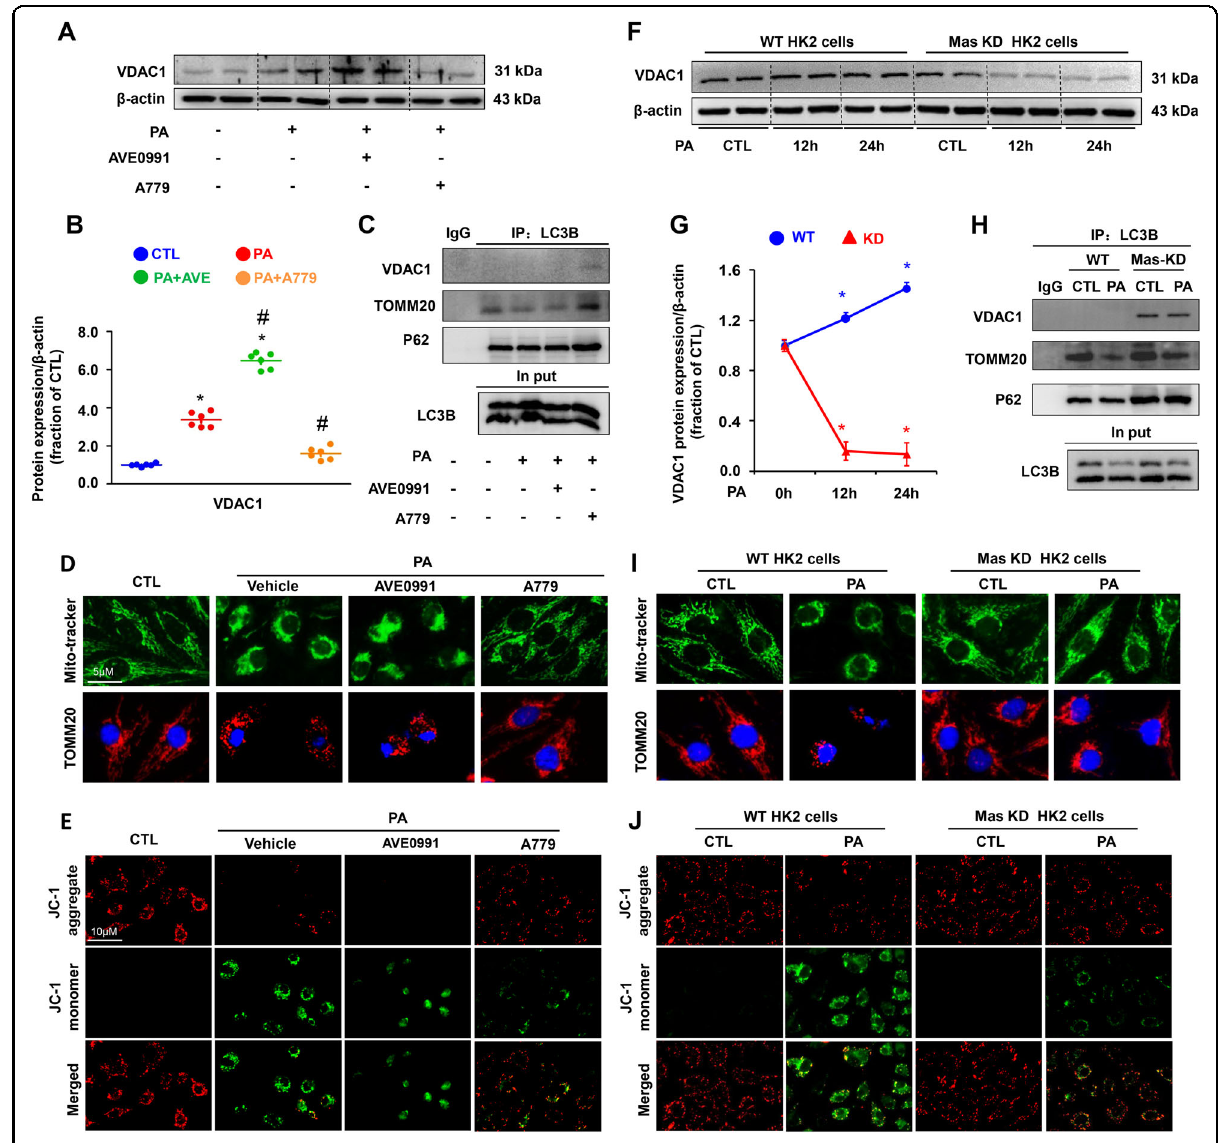
Fig. 6 Mas activation was associated with increased VDAC1 expression and impaired mitochondrial morphology and potential in HK2 cells treated with PA. A and B Representative immunoblots and corresponding densitometry analysis of VDAC1 protein abundance in HK2 cells pretreated with AVE0991 or A779 followed by PA for 24 h. β -actin was used as a loading control. C VDAC1 and TOMM20 were detected by LC3 tag labeling in HK2 cells pretreated with AVE0991 or A779 followed by PA for 24 h. D Confocal microscopy images of Mito-tracker (green) and TOMM20 (red) in HK2 cells pretreated with AVE0991 or A779 followed by PA for 24 h. E Representative images of JC-1 staining showing JC-1 aggaregate (red) and monomer (green) in HK2 cells pretreated with AVE0991 or A779 followed by PA for 24 h. F and G Representative immunoblots and corresponding densitometry analysis of VDAC1 protein abundance in WT and Mas knockdown (KD) HK2 cells treated with PA for 12 h and 24 h. H Mitochondrial proteins VDAC1 and TOMM20 were detected by LC3 tag labeling in WT and Mas knockdown HK2 cells treated with PA for 24 h. I Confocal microscopy images of Mito-tracker (green) and TOMM20 (red) in WT and Mas knockdown HK2 cells treated with PA for 24 h. J Representative images of JC-1 staining showing JC-1 aggaregate (red) and monomer (green) in WT and Mas knockdown HK2 cells treated with PA for 24 h. WT, wild type; Mas KD, Mas knockdown Data are shown as mean ± SEM; * P < 0.05 compared with CTL; # P < 0.05 compared with PA. The experiment was repeated three